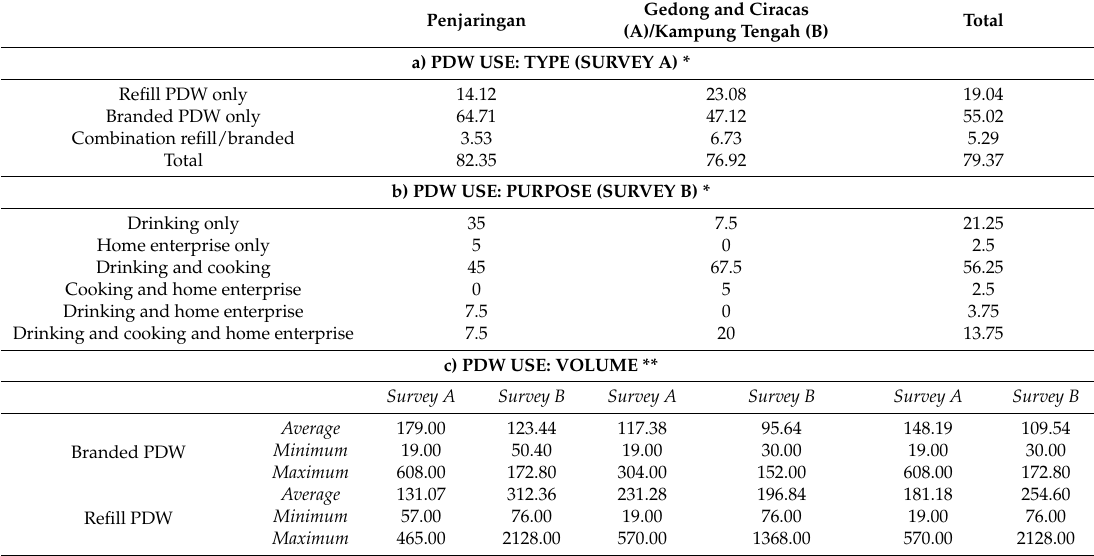
Table 2. Overview of PDW consumption patterns in northern and southern research locations according to type ( a ), purpose ( b ), and quantity ( c ). (Source: